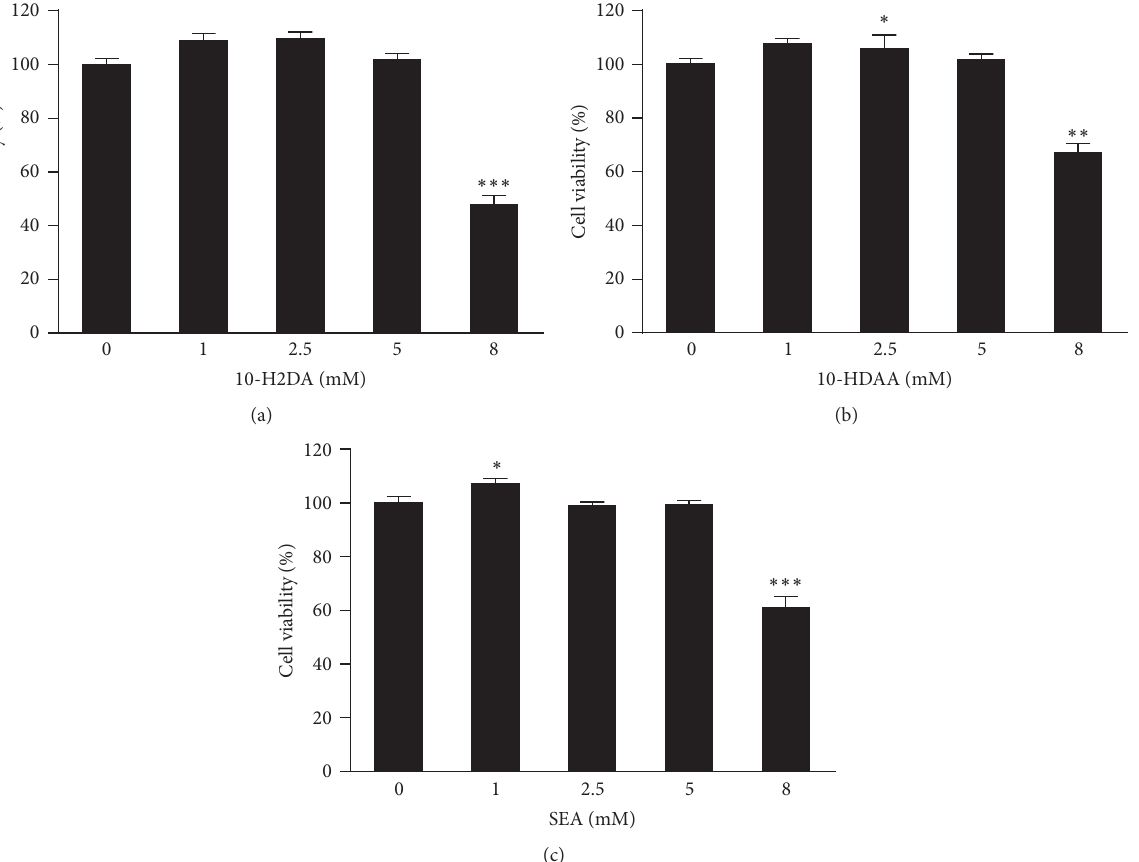
Figure 2: Effects of 10-H2DA, 10-HDAA, and SEA on the viability of RAW 264.7 cells. RAW 264.7 cells were treated with the indicated concentrations of 10-H2DA (a), 10-HDAA (b), and SEA (c) (0–8mM) for 24 h, and the results are expressed as percentages of surviving cells over control cells, by CCK-8 assays. The data are the means ± SEMs for three independent experiments. ∗ 𝑃 < 0.05 , ∗∗ 𝑃 < 0.01 , and ∗∗∗ 𝑃 < 0.001 versus control cells by Student’s t